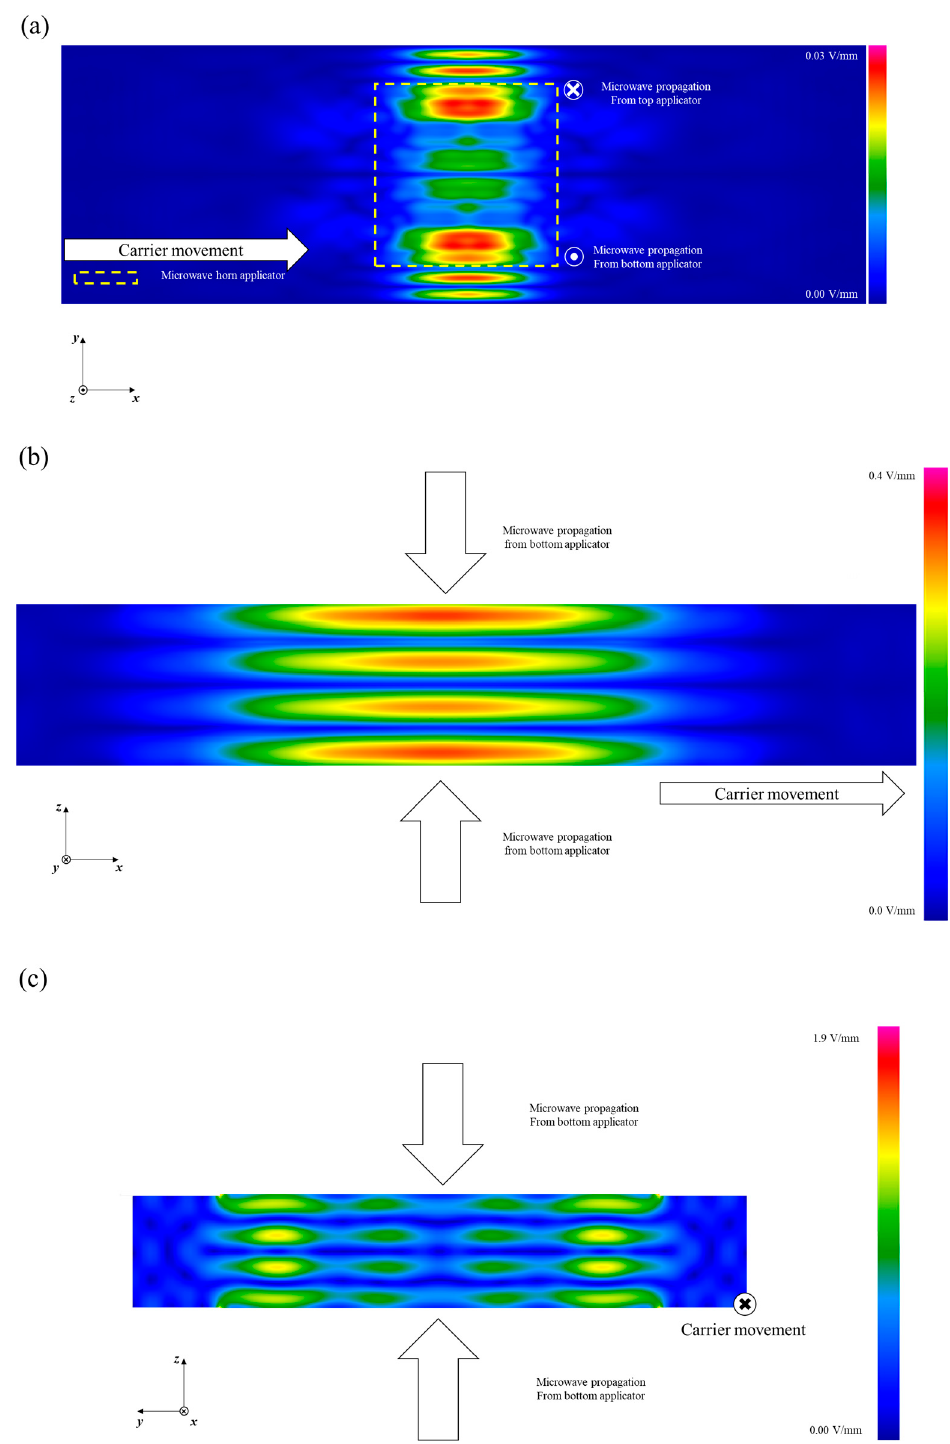
Figure 2. Time average electric field in the empty cavity of the MATS system. ( a ) x–y plane, ( b ) x-z plane, and ( c ) y–z plane (scales are adjusted for better electric field visualization).